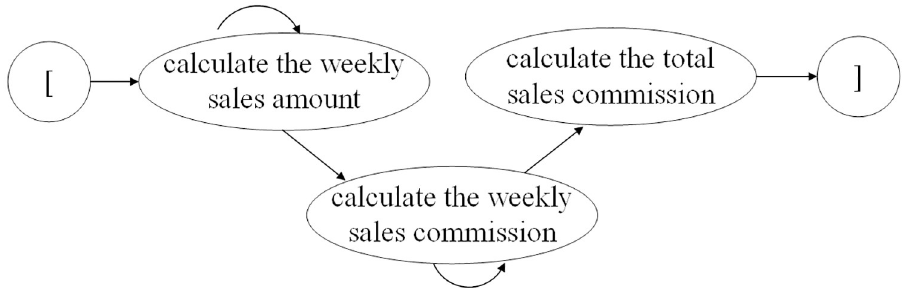
Fig 5. ESG for the process of multistep